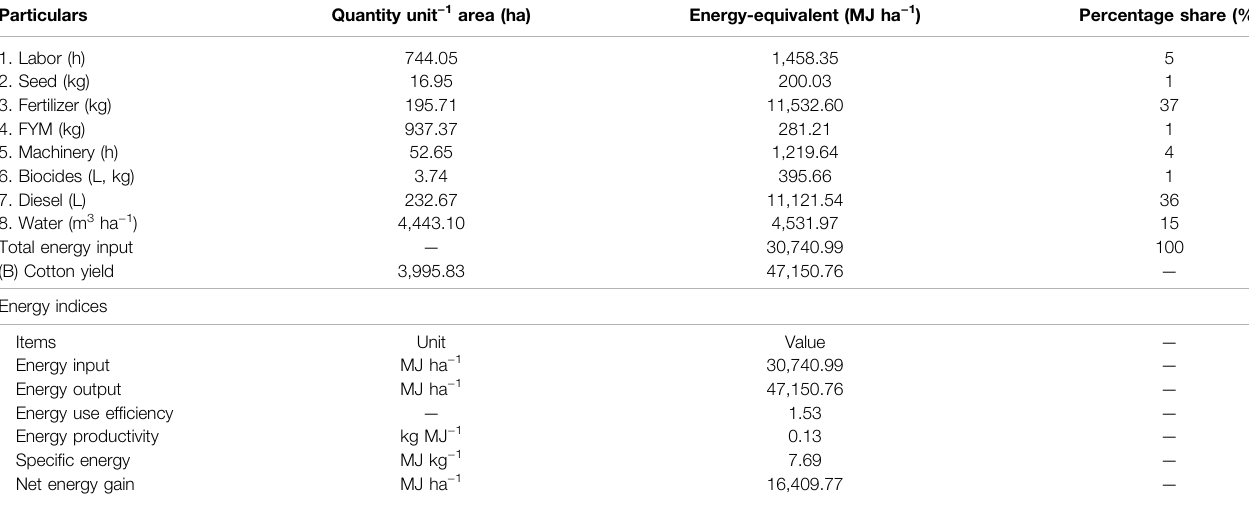
TABLE 2 | Equivalent amount of energy input – output.